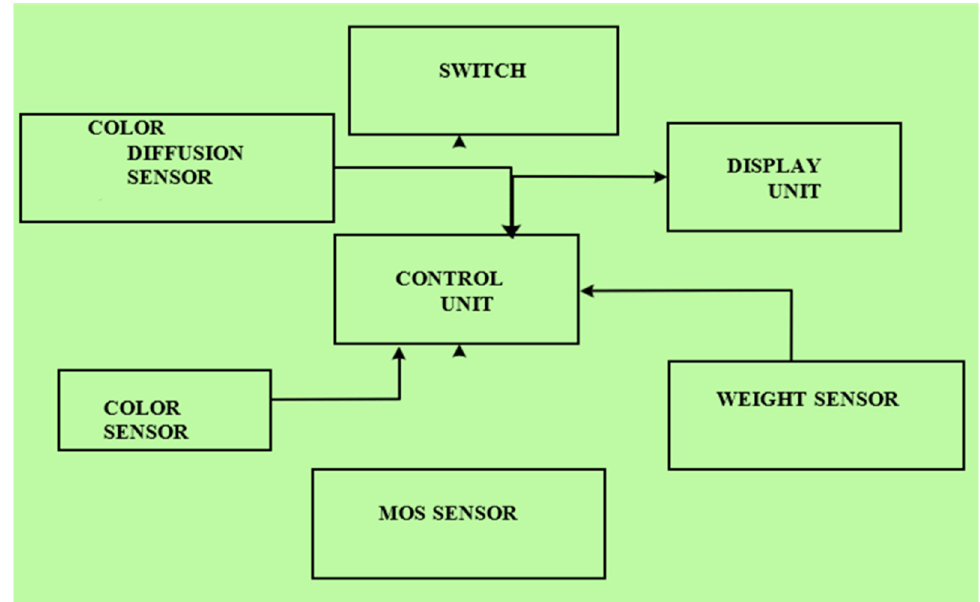
Figure 6. Block diagram of the quality check chamber.